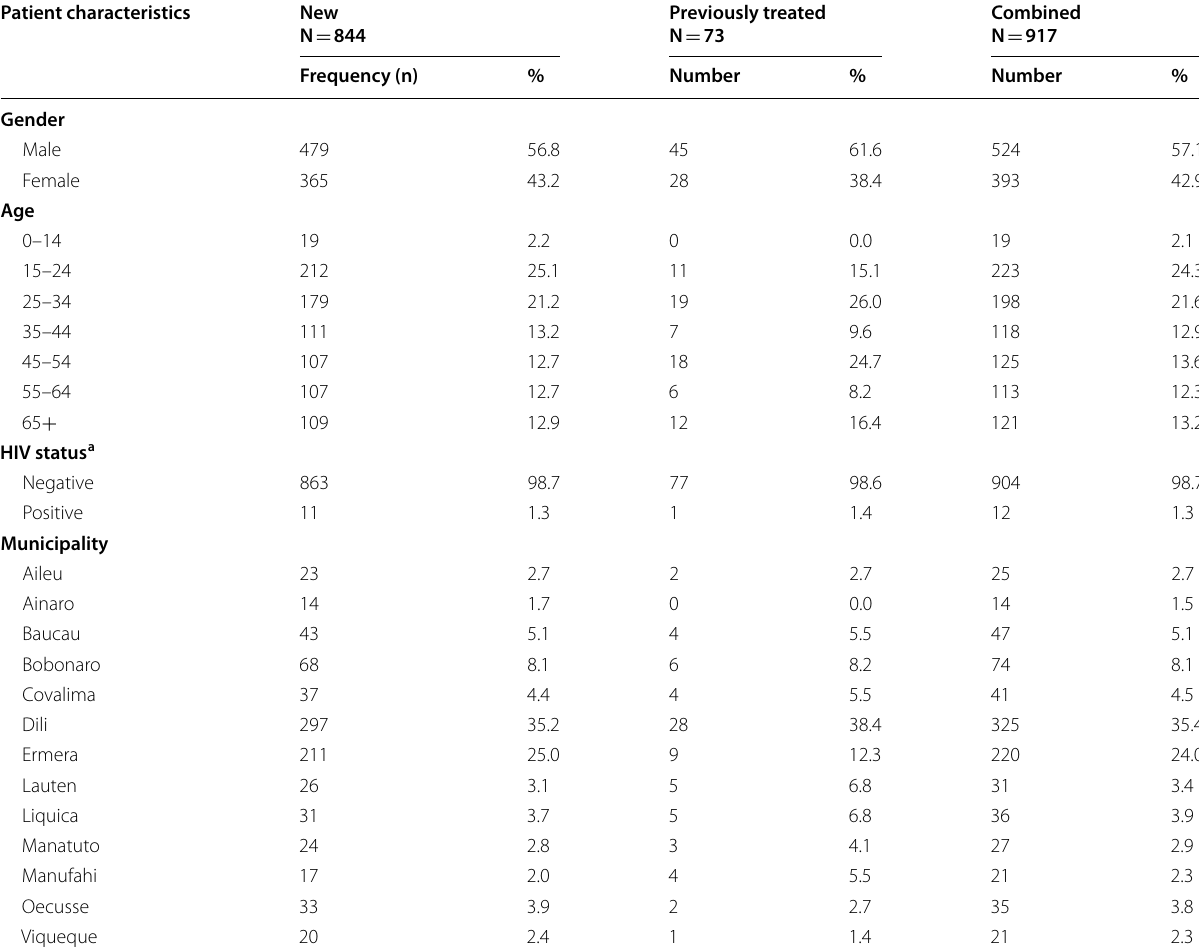
a One new TB patient with missing HIV status